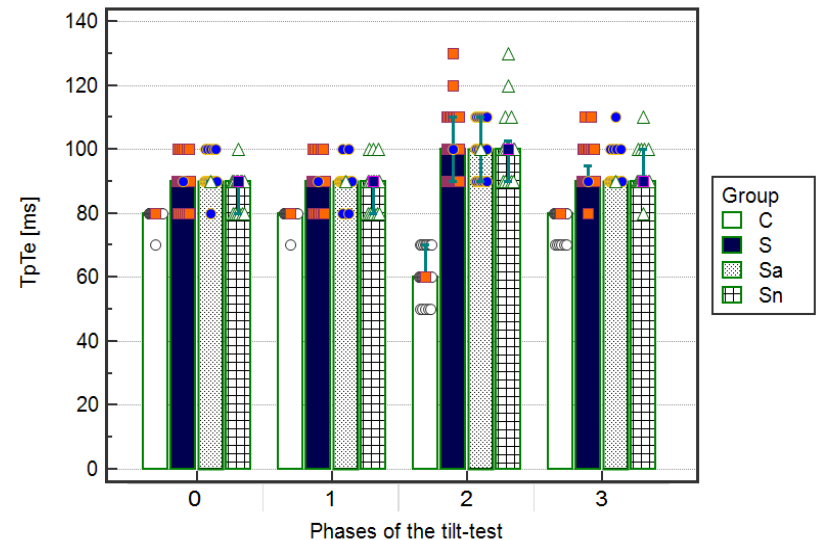
Figure 4. Values of TpTe intervals in ECG on admission to hospital (Phase 0), the resting supine phase (Phase 1), the upright phase (Phase 2), and the returning to supine phase (Phase 3) in the groups: S—syncopal, C—control, Sa—syncopal with abnormal T, Sn—syncopal with normal T. Values [ms]